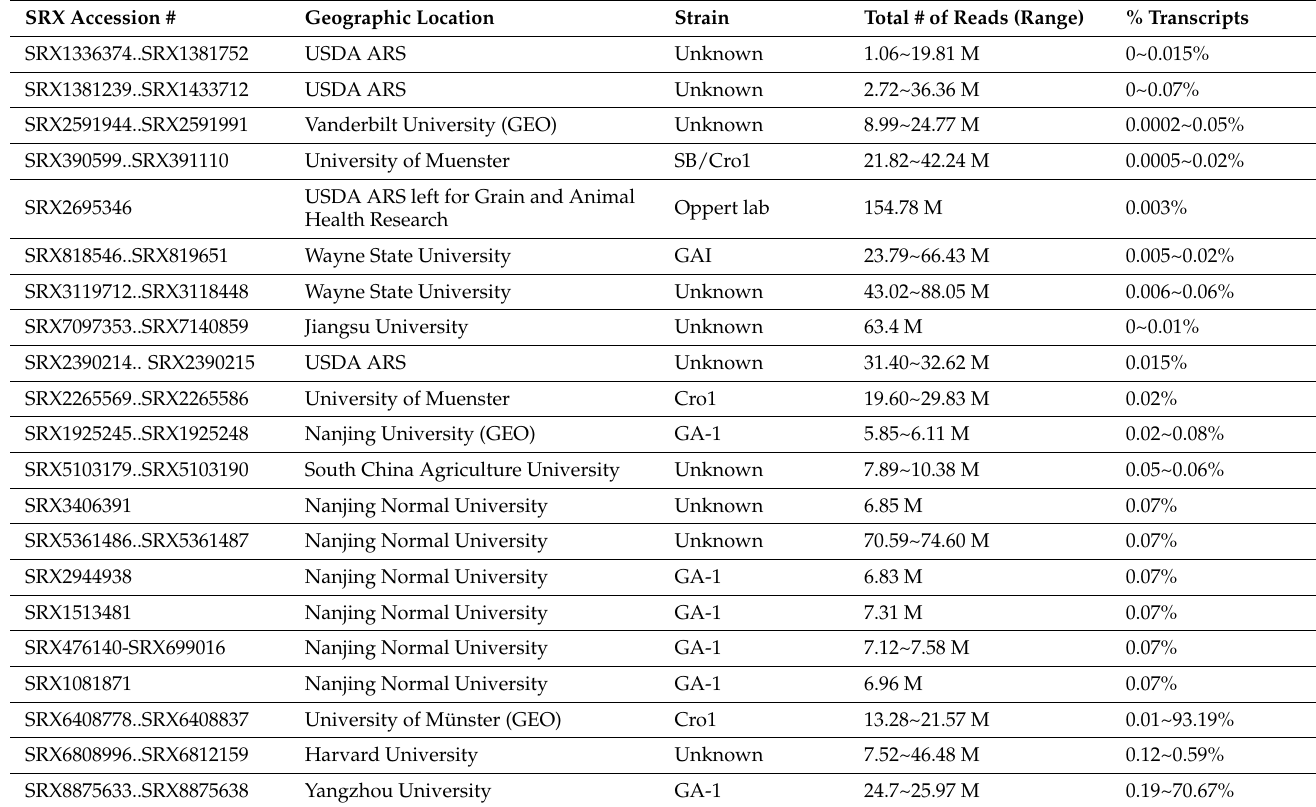
Table 2. The summary of SRA data containing TcIV ranked from low to high. The percent transcript is based on the hit numbers in BLASTN search and NCBI